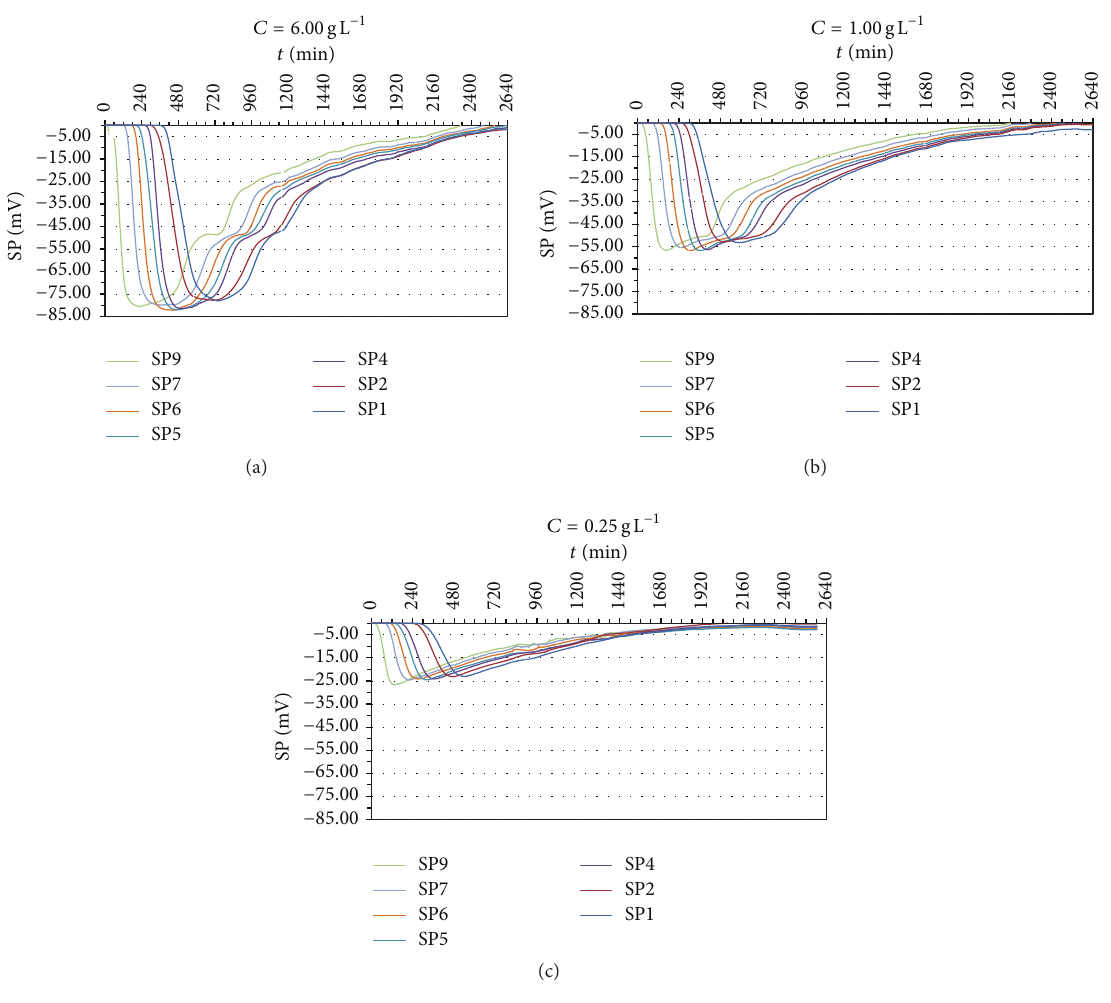
Figure 5: SP data measured during the tracer test with a salt concentration of (a) 6.00 gL −1 , (b) 1.00g L −1 , and (c) 0.25 gL −1 .